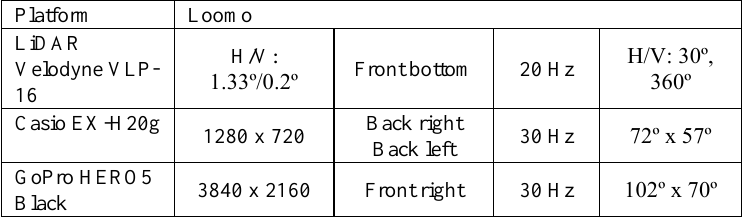
Table 1. Sensor specification of the UGV